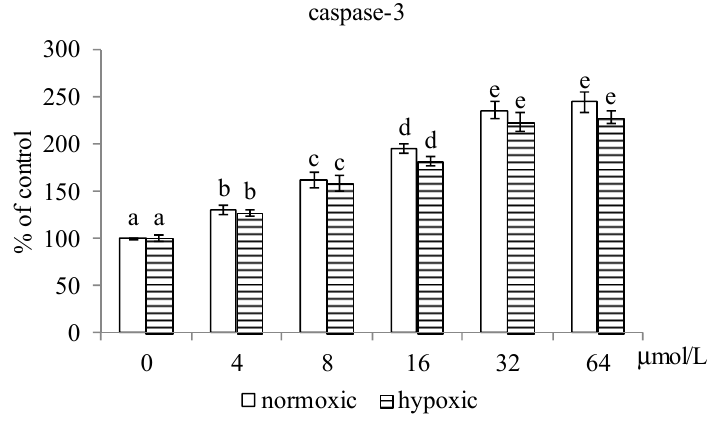
Figure 4. Effects of MA at 0, 4, 8, 16, 32 or 64 μ mol/L upon activity of caspase-3 and caspase-8 in A549 cells under normoxic and hypoxic conditions. Data are mean ± SD ( n = 10). a–e Means among bars in the same condition without a common letter differ, p < 0.05. # Means significantly different from normoxic conditions at the same dose at p <